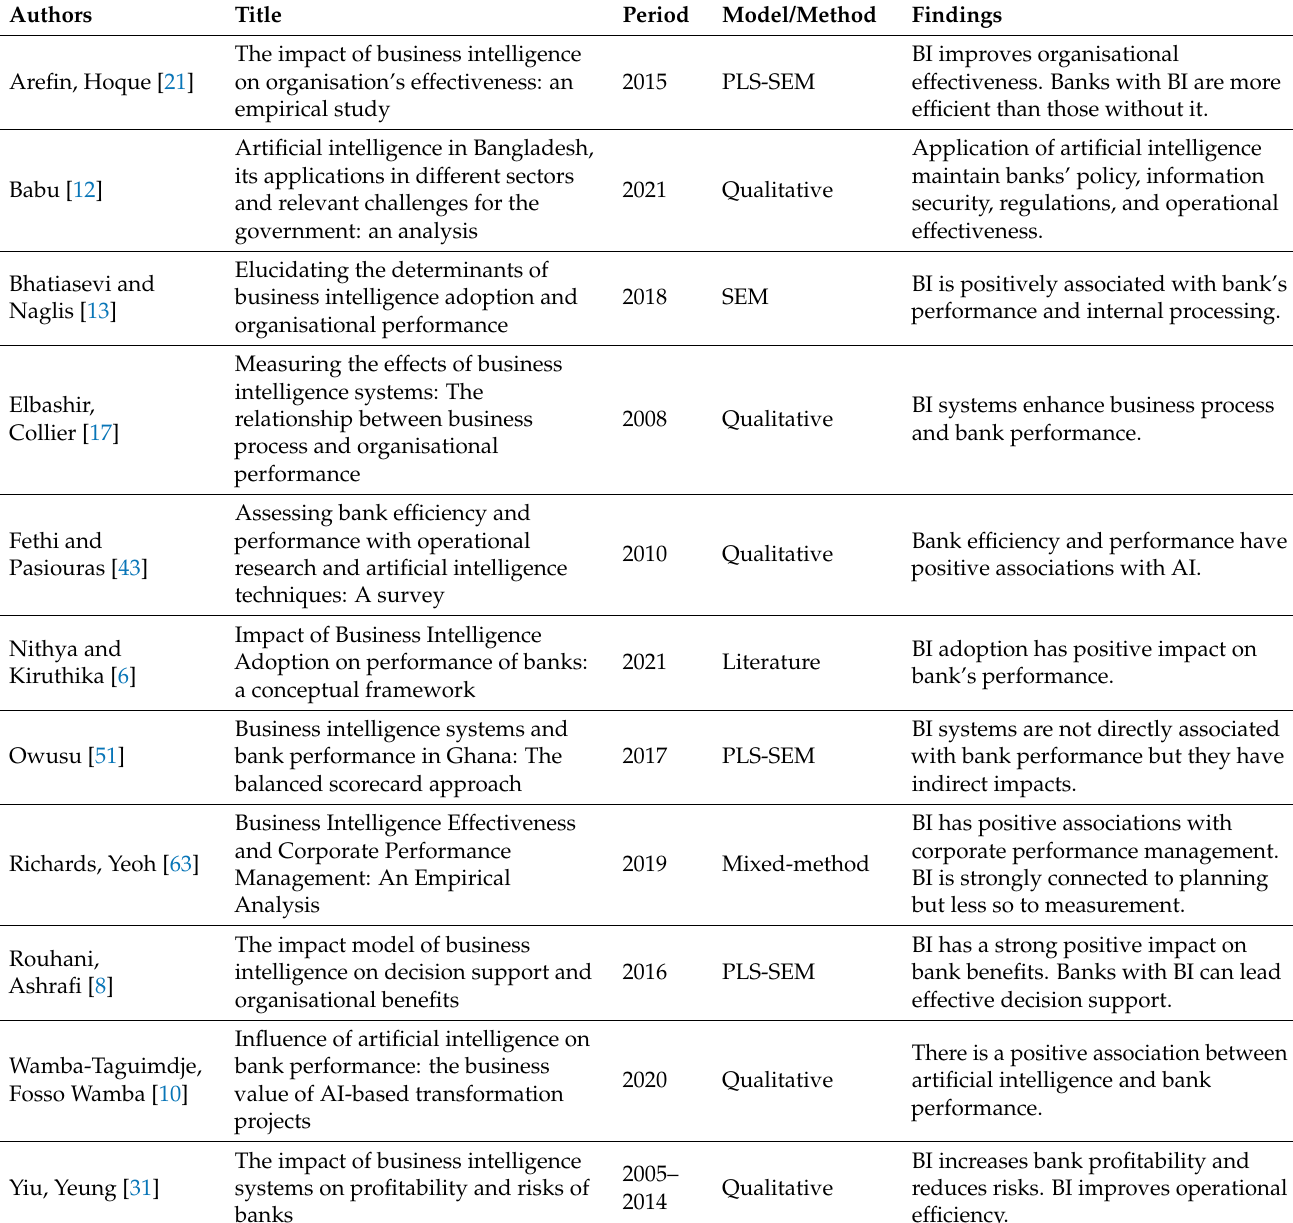
Table A1. Review of existing studies on BI, bank’s operational efficiency and